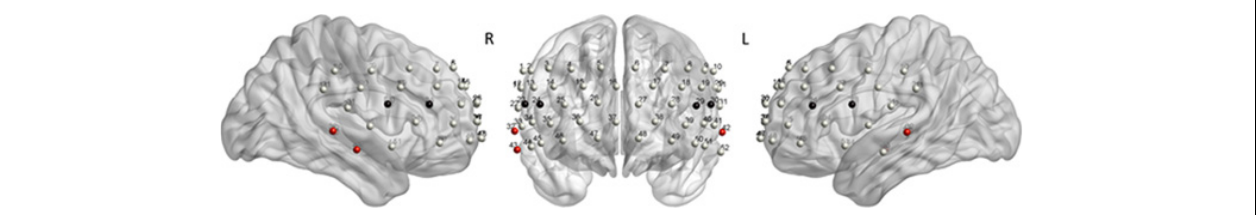
FIGURE 4 | Quantile analysis: Main effects. Schematic front and side views of the fNIRS probe setup with 52 channels (gray). ROI DLPFC: Channels 23/24 (right) and 29/30 (left) reflected significant main effects of ‘quantile,’ ‘interference,’ and ‘group’ (black). ROI MTG: Channels 32/43 (right) and 42 (left) reflected a significant main effect of ‘group’ (red). The MATLAB toolbox NFRI (Singh et al., 2005) was used to estimate the Montreal Neurological Institute (MNI) coordinates of the 10–20 positions. Channels were visualized using BrainNet Viewer (Xia et al., 2013) ( Table 6 ).